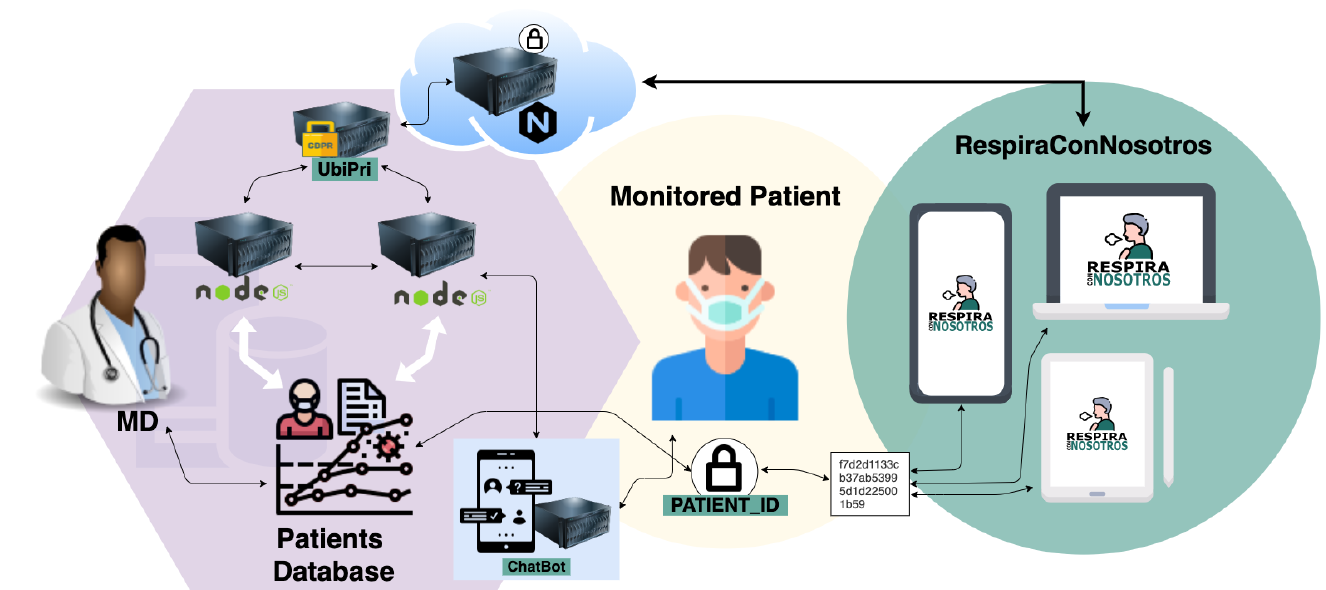
Figure 2. Architecture of rehabilitation application.